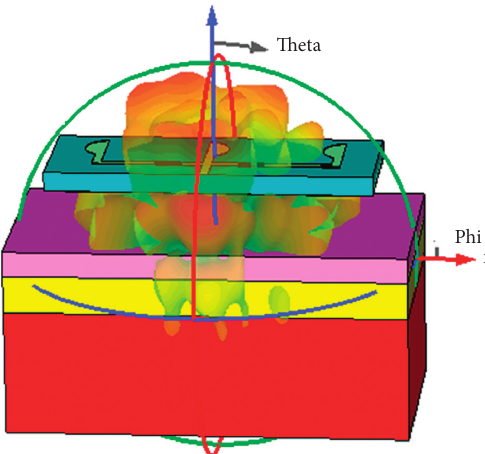
Figure 28: Array 3 on-body 3D radiation pattern at 60GHz.